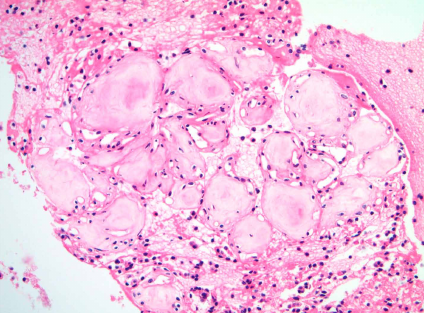
Figure 7: The cell block showed loose collections of small epithelioid cells and in some areas connected disc-like spheres of hyalinized fibrous tissue with adherent/intrinsic bland spindle cells, suggesting a possible papillary/arborizing morphology (Hematoxylin & eosin stain,